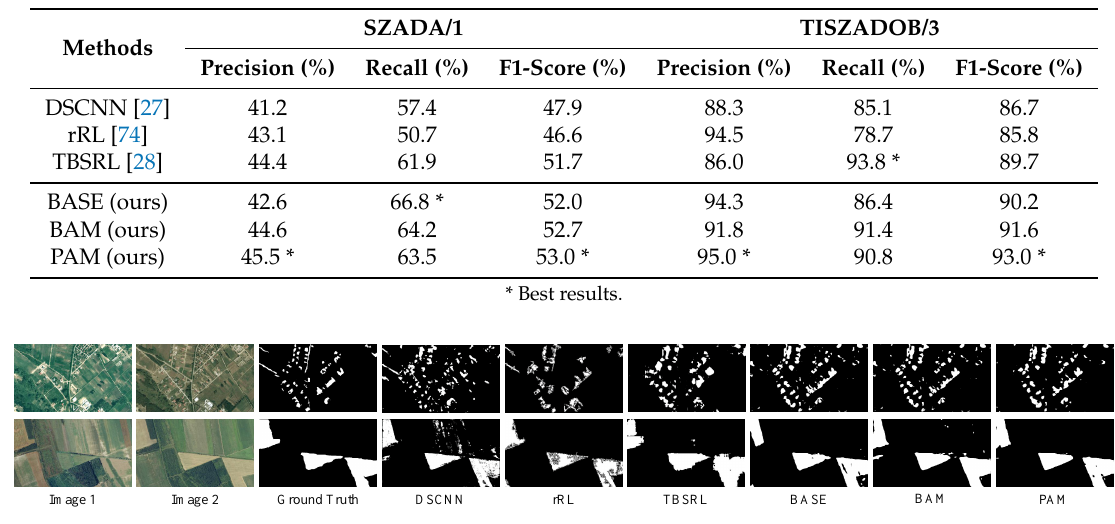
Figure 8. Change detection examples of different methods on the SZTAKI dataset. Each row Visualization results of different methods on the SZTAKI dataset. Each row represents one sample and its predicted results (first row: SZADA / 1 data, second row: TISZADO / 3 data). The first three columns are image 1, image 2 and ground truth. The middle three columns display the results of state-of-the- represents one sample and the predictions of different methods (first row: SZADA/1 data, second row: art methods. The last three columns are the results of our baseline and its variants. TISZADO/3 data).